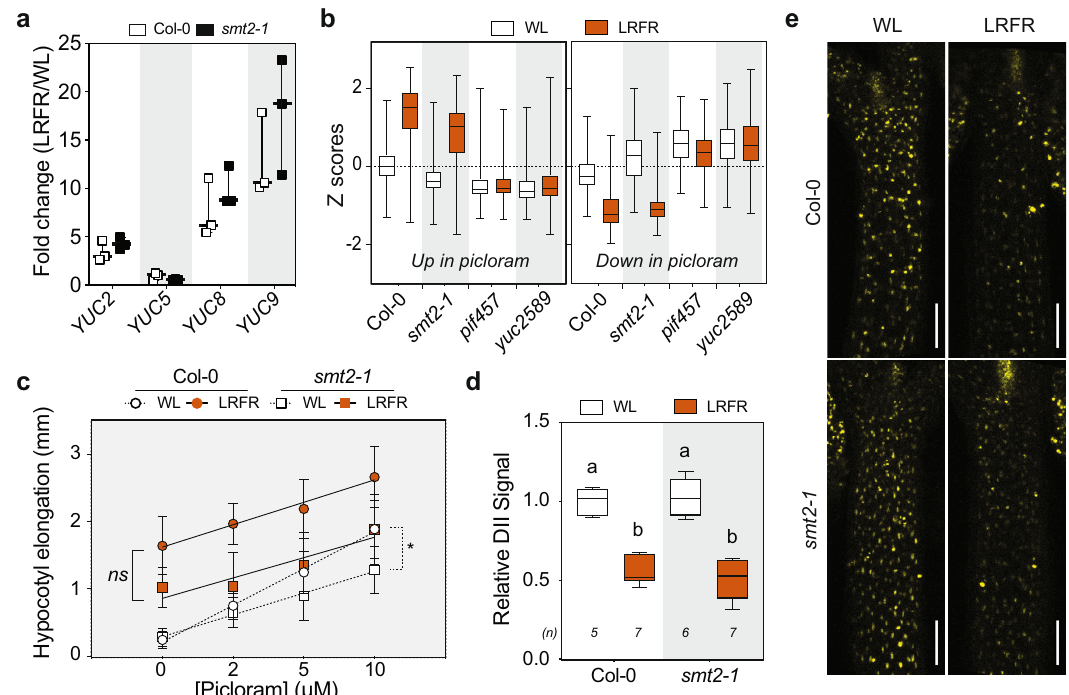
Fig. 5 | Auxin biosynthesis, response, and transport are normal in smt2-1 in LRFR.a LRFR-induction of auxin biosynthetic genes in the indicated genotypes (data from RNA-seq). Each data point indicates biologically independent sam- ples, the horizontal bar represents the median, whiskers extend to show the data range. b Distributions of Z-scores computed from replicates averages for synthetic auxin picloram up- and downregulated genes in hypocotyls of the indicated genotypes (as listed in ref. 55). c Hypocotyl elongation of indicated genotypes with the indicated doses of picloram. Data are means ±SD with a regression line. d , e Quanti fi cation ( d ) and the representative images ( e ) of the DII-VENUS signal intensity (normalized to mean value of Col-0 in WL) in hypocotyls of the indicated genotypes either kept at WL or transferred to LRFR for 1h. White bars equal to 100 µ m. b , d The horizontal bar represents the